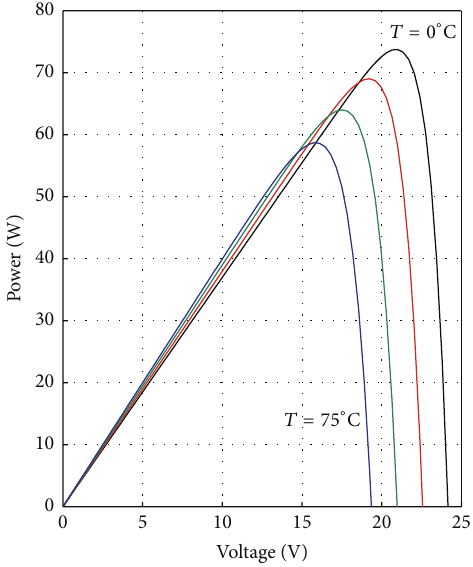
Figure 6: MATLAB model 𝑃 - 𝑉 curves for various